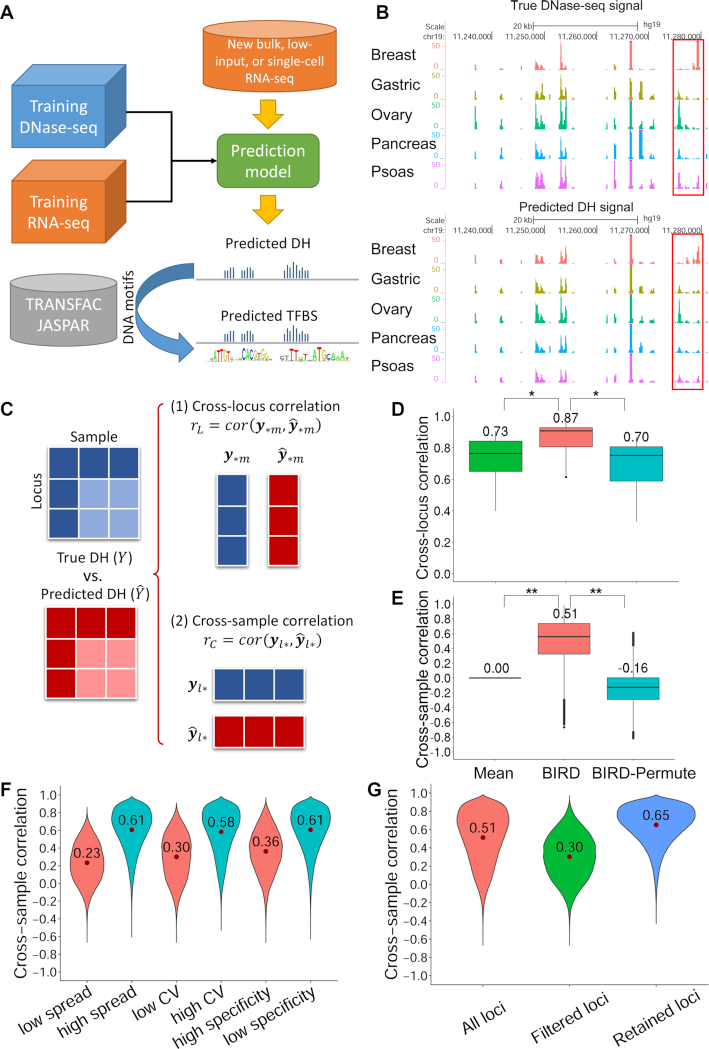
Overview of the study design and BIRD prediction performance using bulk RNA-seq. (A) Study design. Bulk DNase-seq and RNA-seq data from Roadmap Epigenomics or ENCODE are used to train BIRD prediction models which are then applied to new RNA-seq samples to predict DH. The predicted DH can be coupled with DNA motifs to predict TFBSs. (B) An example of true and predicted DH signals across five different samples. Each track is a sample. Regions highlighted with boxes demonstrate that the predicted DH captures the true DH variation. (C) Statistics used to evaluate prediction accuracy. (D) Distribution and mean of the prediction-truth correlation rL from all samples for three prediction methods: BIRD, random prediction models (‘BIRD-permute’) and the mean DH profile of training data (‘Mean’) in leave-one-cell-type-out cross-validation. *Two-sided Wilcoxon signed-rank test P-values < 10−12 for comparing two methods (n = 70 for each test). (E) Distribution and mean of the prediction-truth correlation rC for comparing different methods. **Two-sided Wilcoxon signed-rank test P-values < 10−15 for comparing two methods (n = 1 136 465 for each test). (F) Distribution and mean of rC for different categories of loci. Regulatory elements were divided into two groups (low or high) based on different factors (Supplementary Methods): max-min spread of DH signal, coefficient of variation (CV), or cell-type-specificity. (G) Distribution of rC for all loci, loci filtered out by factors in (F) (i.e. low spread, low CV or high specificity), and the remaining loci.